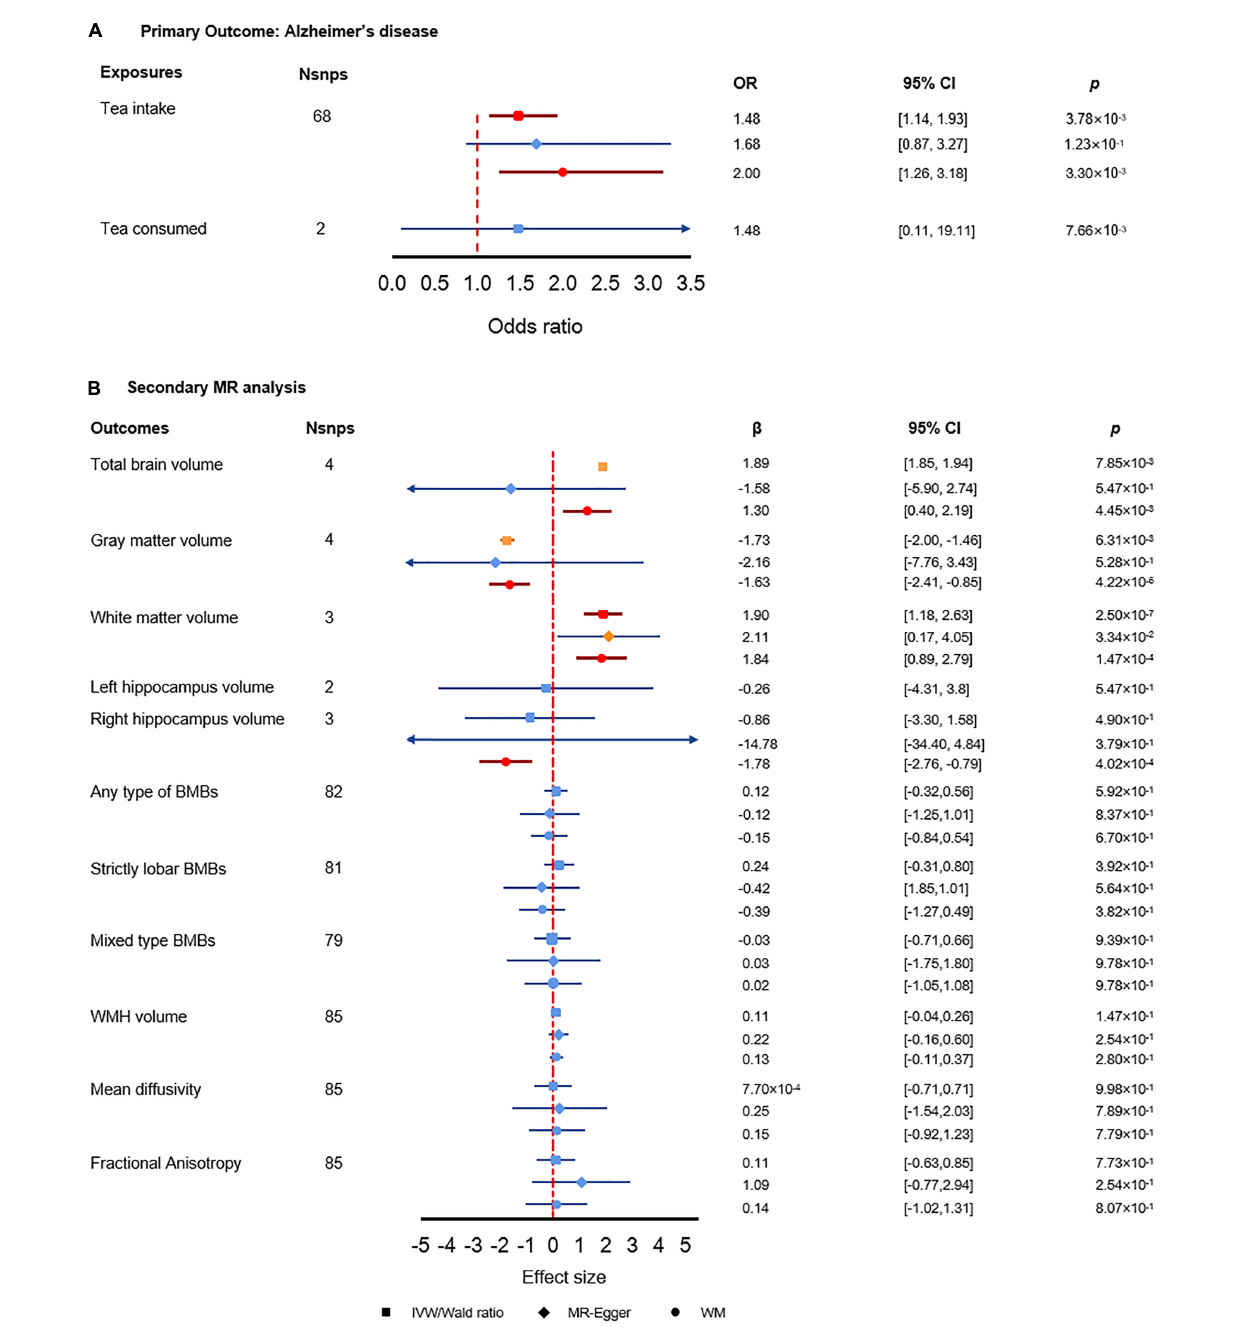
FIGURE3 Results of the primary and secondary Mendelian randomization (MR) analysis. (A) Primary MR analysis results. (B) Secondary MR analysis results. The red color denotes the significant result, the orange color denotes results with p -value less than 0.05 but did not pass the multiple test correction criteria, and the blue color denotes insignificant